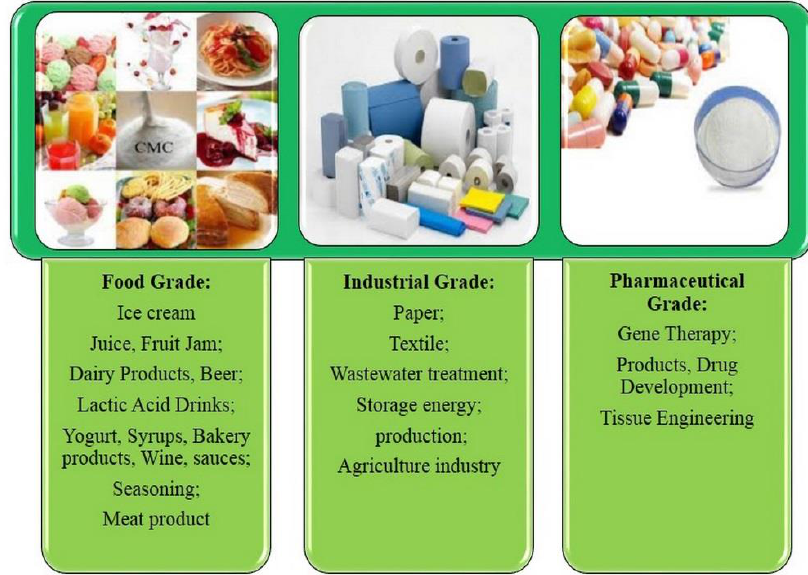
Figure 1. Applications of carboxymethylcellulose (CMC) in different industries.